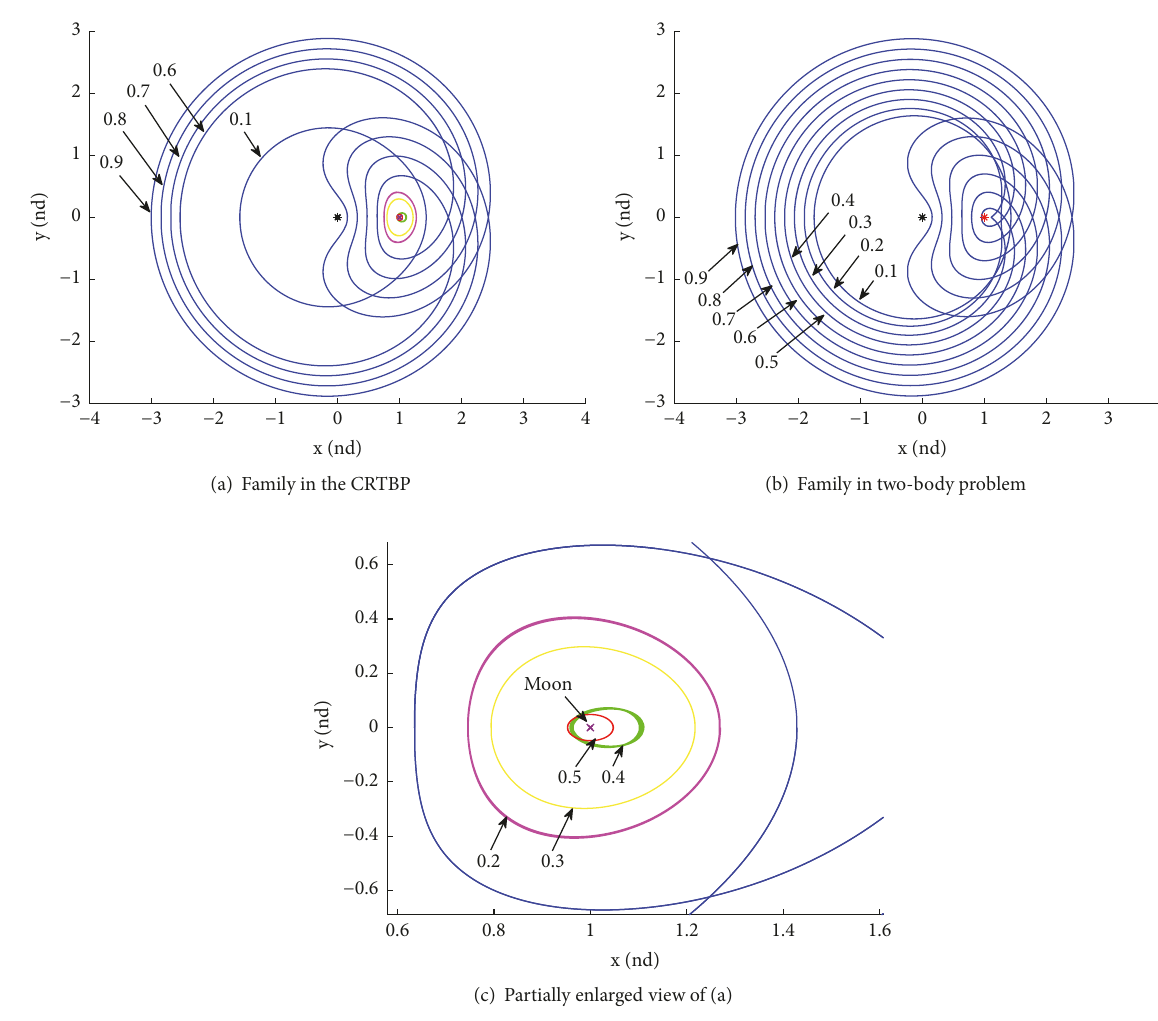
Figure 7: 1:2 resonant family in the CRTBP and two-body